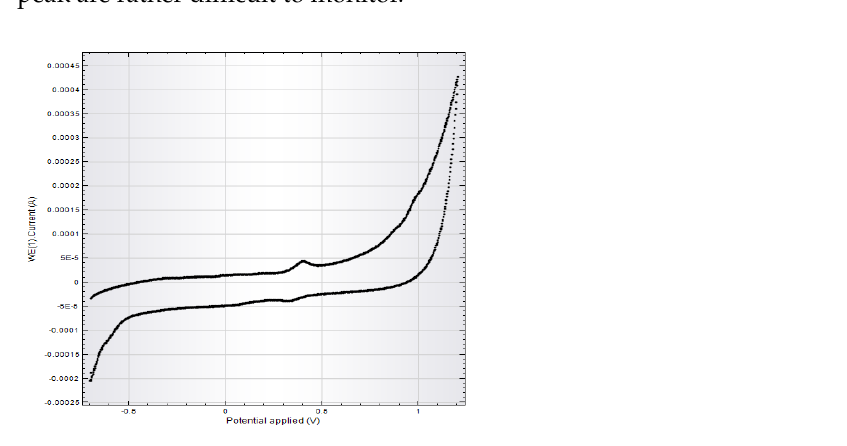
Figure A4. CV registered on graphite-based SPE in the presence of 0.5 mM DPPH ˙ in 0.1 M HClO 4 .